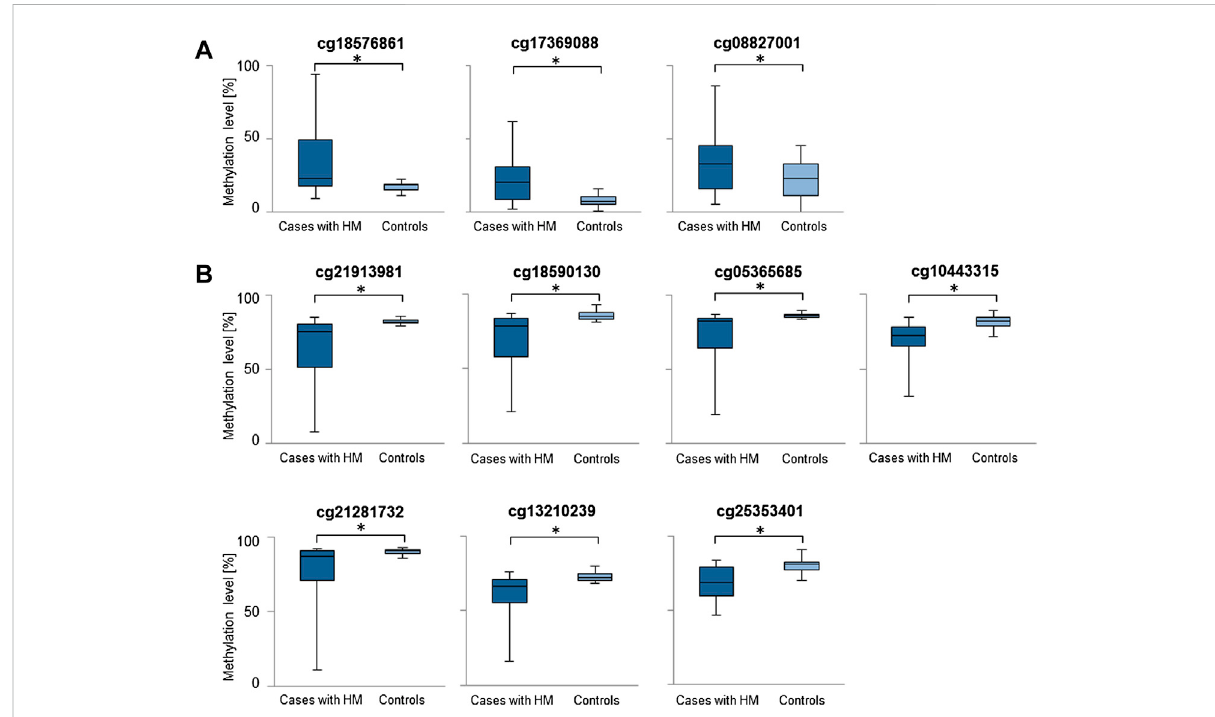
FIGURE 2 Comparisons of methylation levels of the highest-ranked CG dinucleotides between cases with HM and controls. Presented are CG dinucleotides with at least 10% methylation difference between HM cases and controls and location in miRNA encoding genes promoter regions. Standarddeviationisincludedandasterisk(*)standsforthestatisticallysigni fi cantdifferenceinmethylationlevel(FDR-corrected p -value < 0.05). (A) CG dinucleotides with increased methylation level in HM cases versus controls. (B) CG dinucleotides with decreased methylation level in HM cases versus